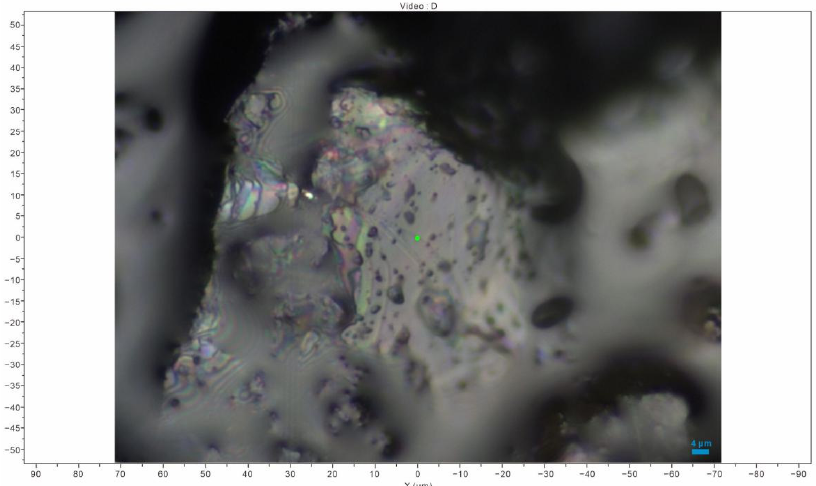
Figure 3. The laser spot size with a scale (magnification: 500×).